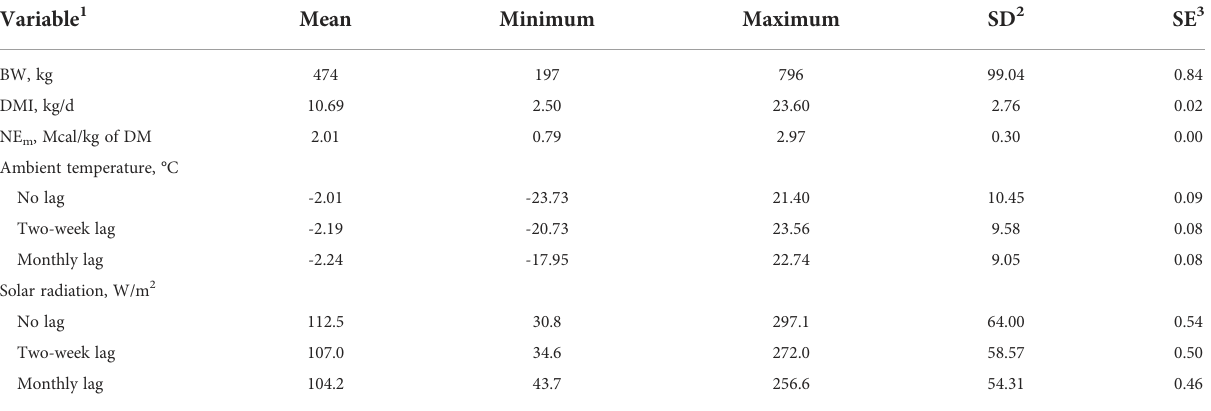
TABLE 2 Descriptive statistics of variables across the period of